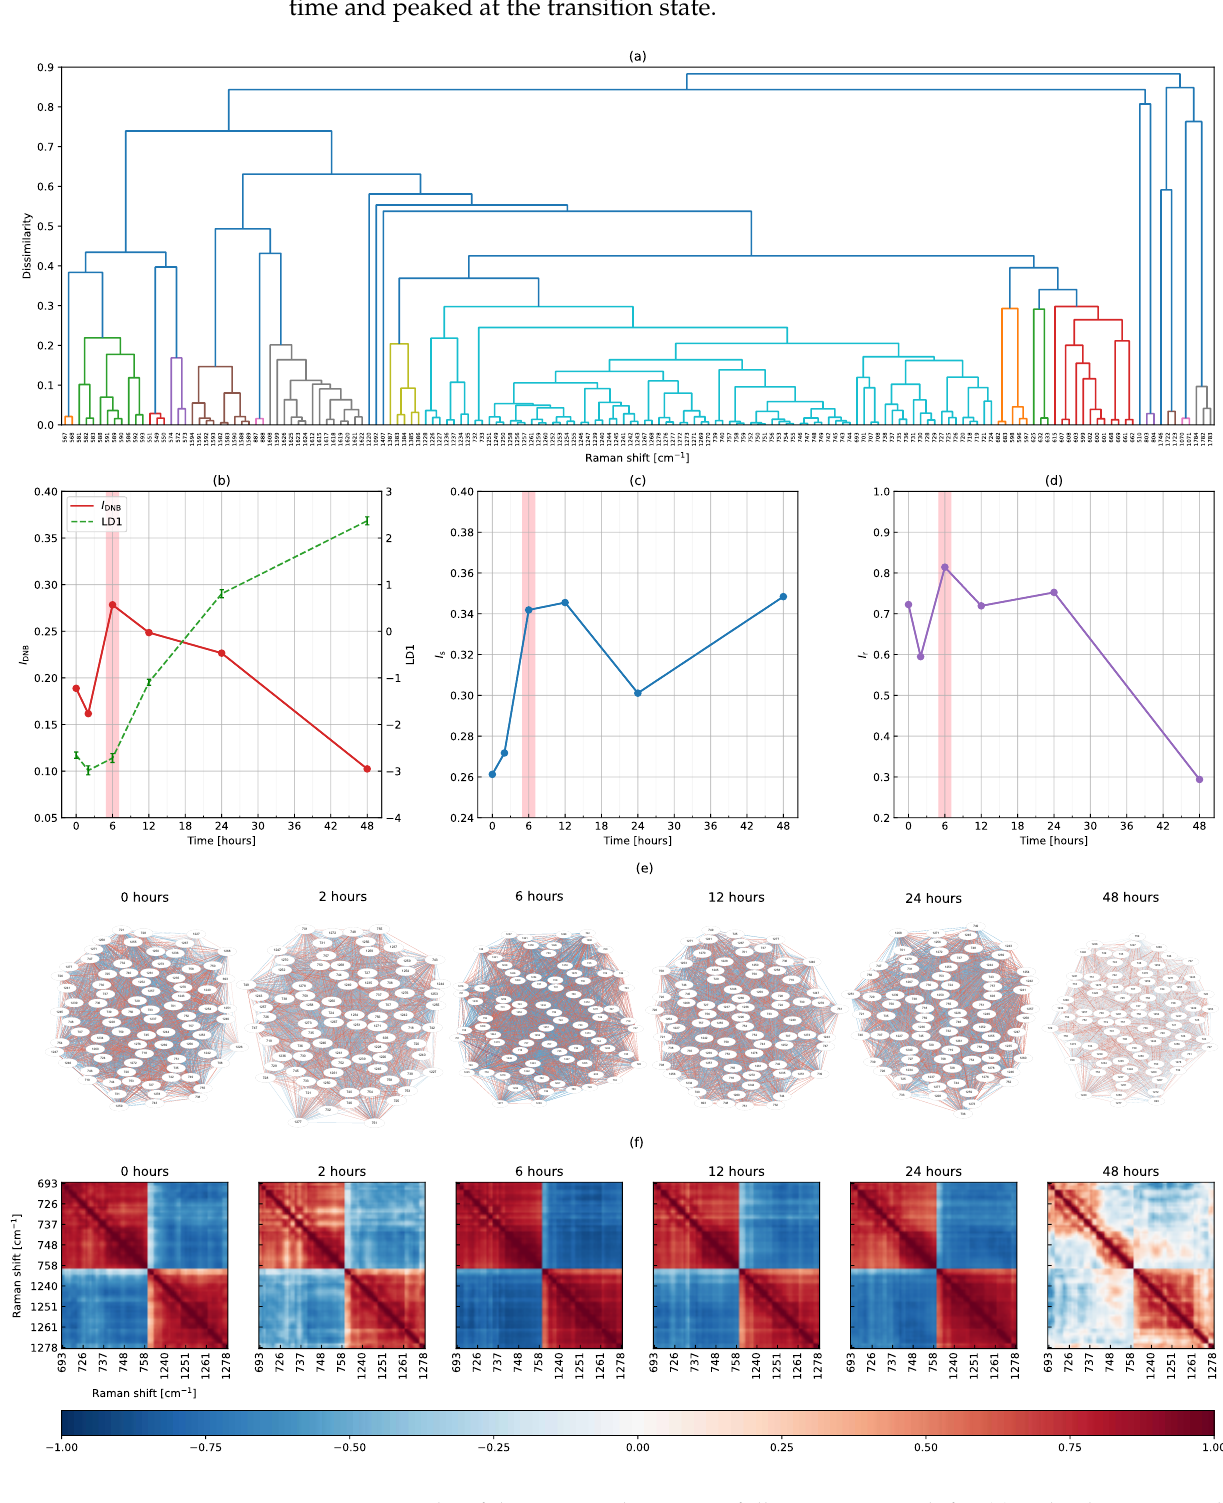
Figure 4. Results of the DNB analysis using full-range Raman shifts. ( a ) A dendrogram produced by the hierarchical clustering of 163 Raman shifts fluctuating at 6 h, the time evolution of ( b ) the DNB score overplotted with the average discriminant score, ( c ) the average standard deviation and ( d ) the average correlation strength among DNB candidates, ( e ) topological structures of the weighted correlation network, and ( f ) correlation coefficients between 81 DNB Raman shifts. In ( b ), the average discriminant score is shown again as the dashed line from Figure